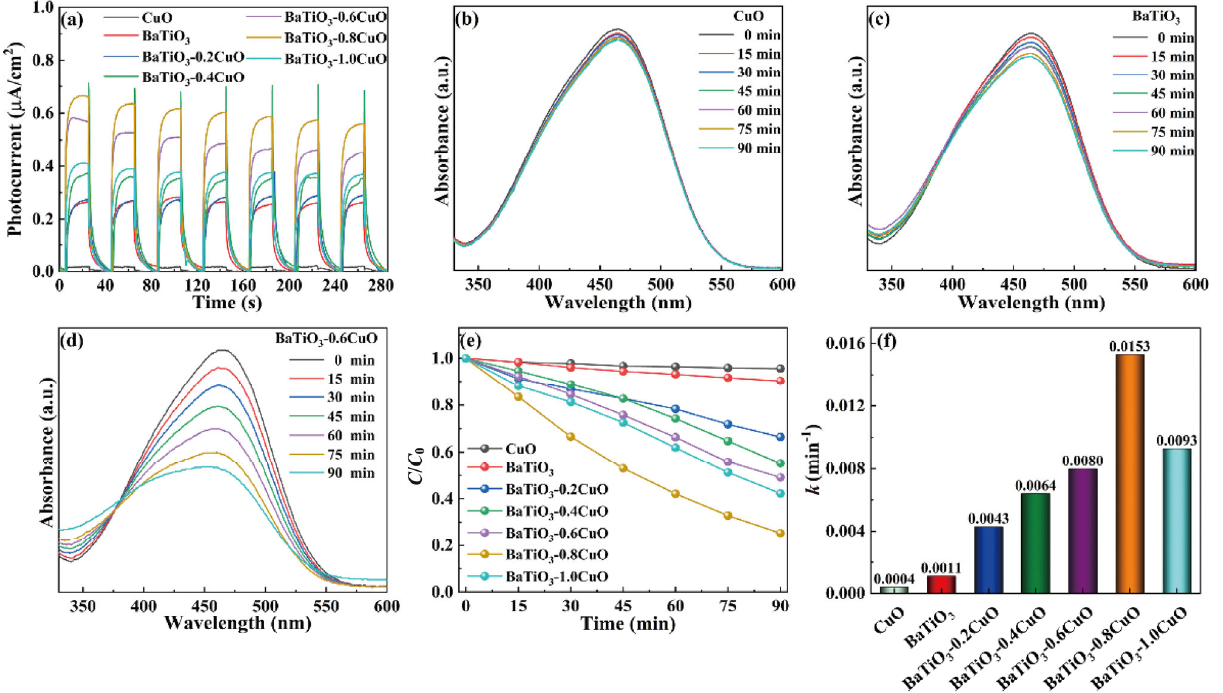
Fig. 4 (a) Transient photocurrent response of BaTiO 3 NWs, CuO NPs, and BaTiO 3 –CuO heterostructures under UV irradiation. UV–Vis absorption spectra of MO solutions undergoing different UV irradiation time for (b) CuO NPs, (c) BaTiO 3 NWs, and (d) BaTiO 3 –0.6CuO. (e) Comparison of photocatalytic activity of MO degradation and (f) corresponding reaction rate constant of